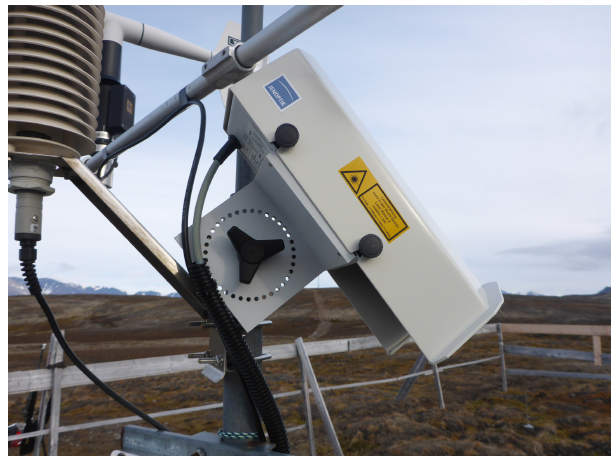
Figure C4. Laser snow depth sensor attached to the climate station, Bayelva, August 2013–present, (78.92094 ◦ N, 11.83334 ◦ E).